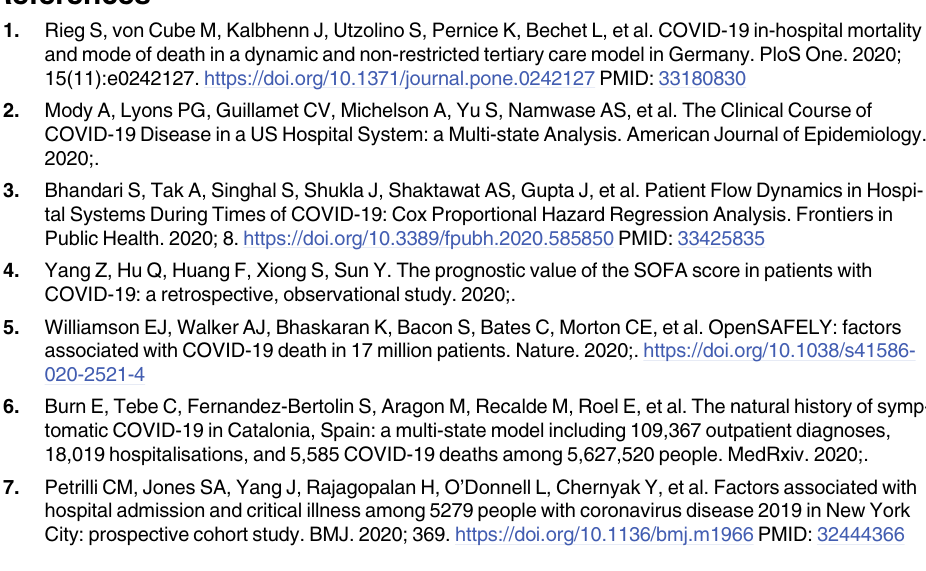
S3 Table. Coefficients and p-values for the final model